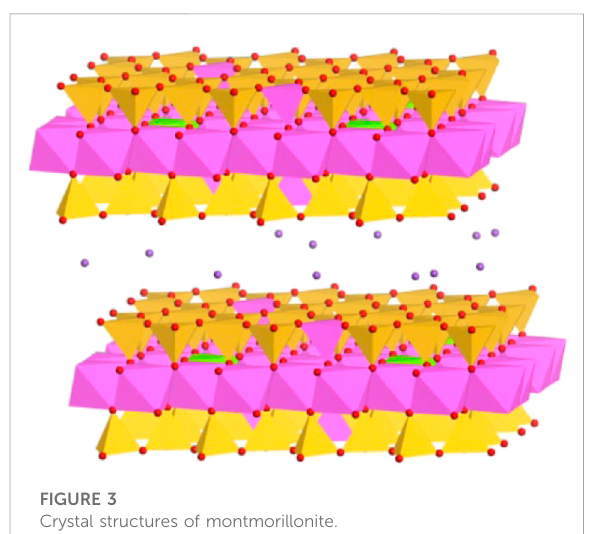
FIGURE 3 Crystal structures of